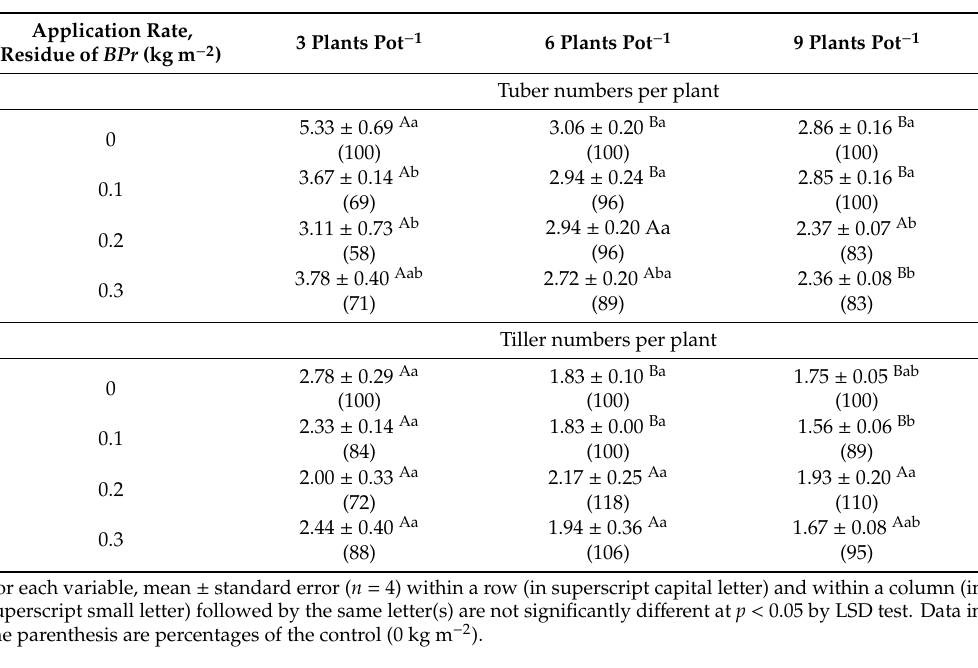
Table 3. The tuber and tiller numbers per plant of CR growing in pot treated with the residue of BPr at four di ff erent application rates.